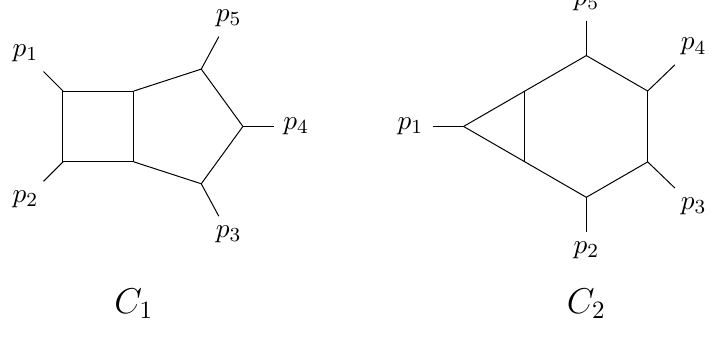
Figure 2 . The integral topologies C 1 and C 2